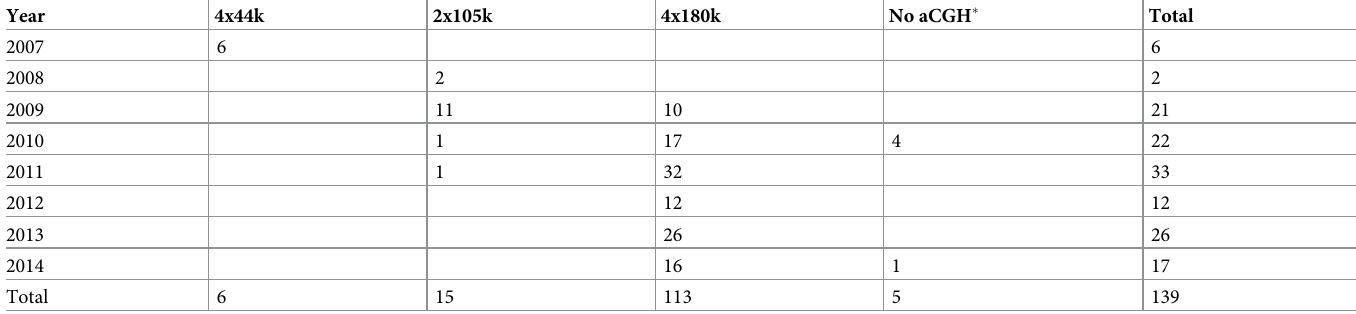
Table 2. The number of submitted tumor pairs categorized per year and used aCGH platform. Note the increase of the number of CGH probes over